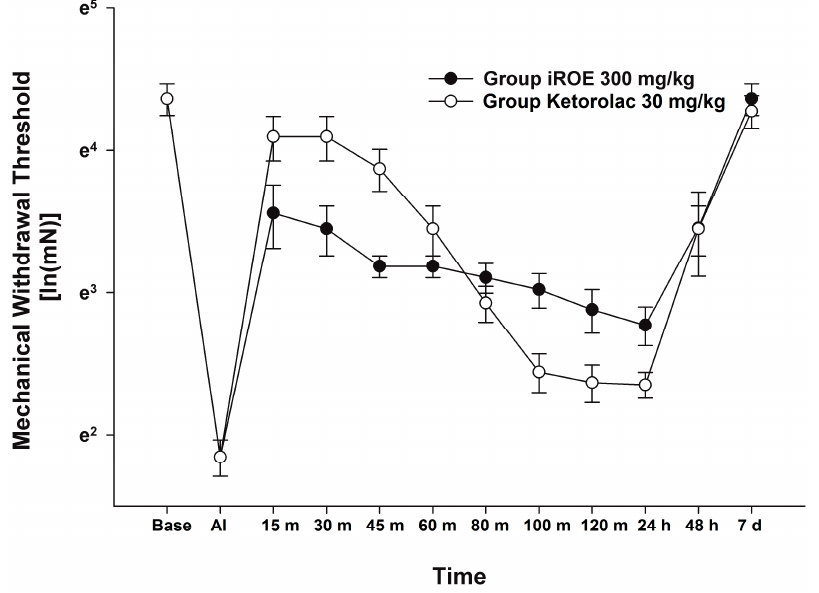
Figure 4. Analgesic effect of immature R. occidentalis vs. ketorolac. iROE, immature Rubus occiden- talis ; AI, after incision.